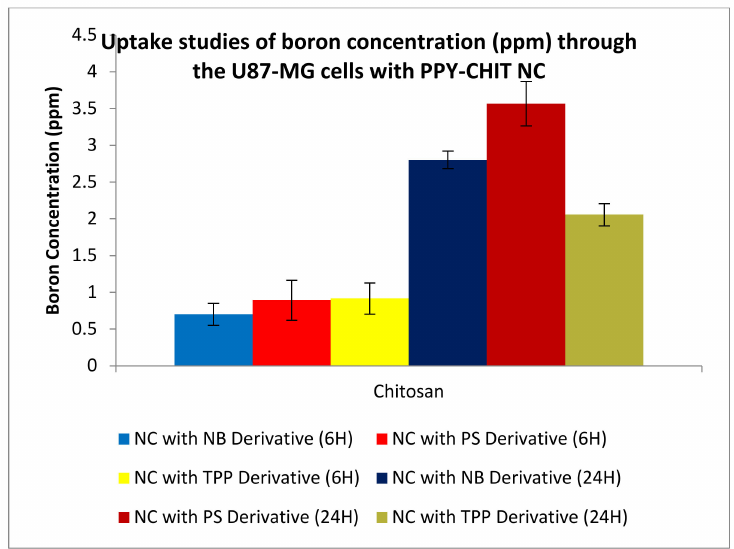
Figure 23. Uptake studies of boron into U87-MG cells from nanocapsules (NC) formulated with chitosan and polypyrrole; uptake of boron was conducted for compound 2 (TPP), compound 4 (NB), and compound 6